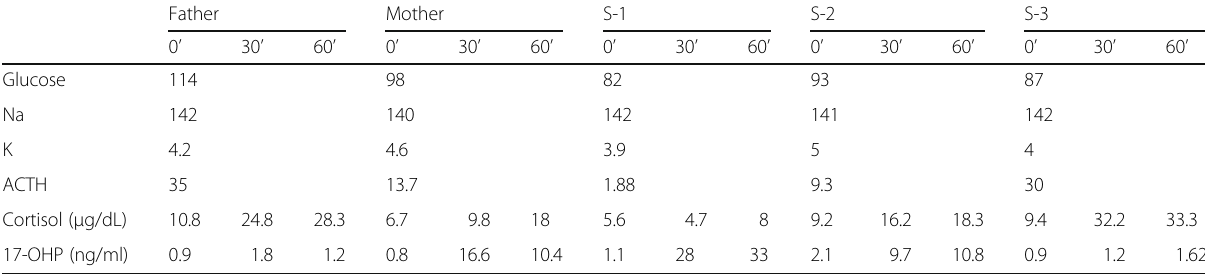
Table 2 ACTH stimulation test among patient and family members